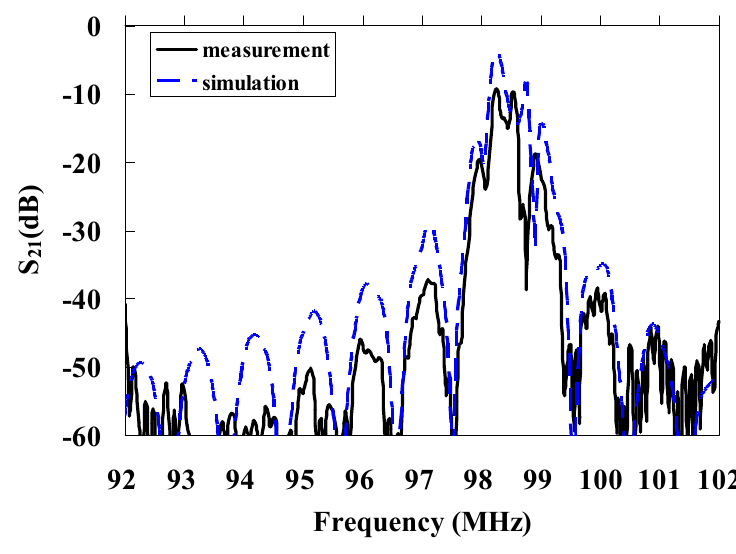
Figure 5. Frequency responses of two-port SAW resonator.